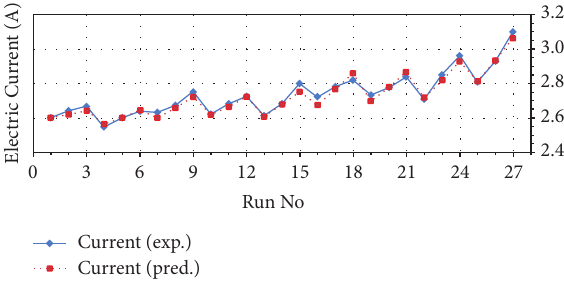
Figure 10: Comparison between predicted and measured values for electric current.